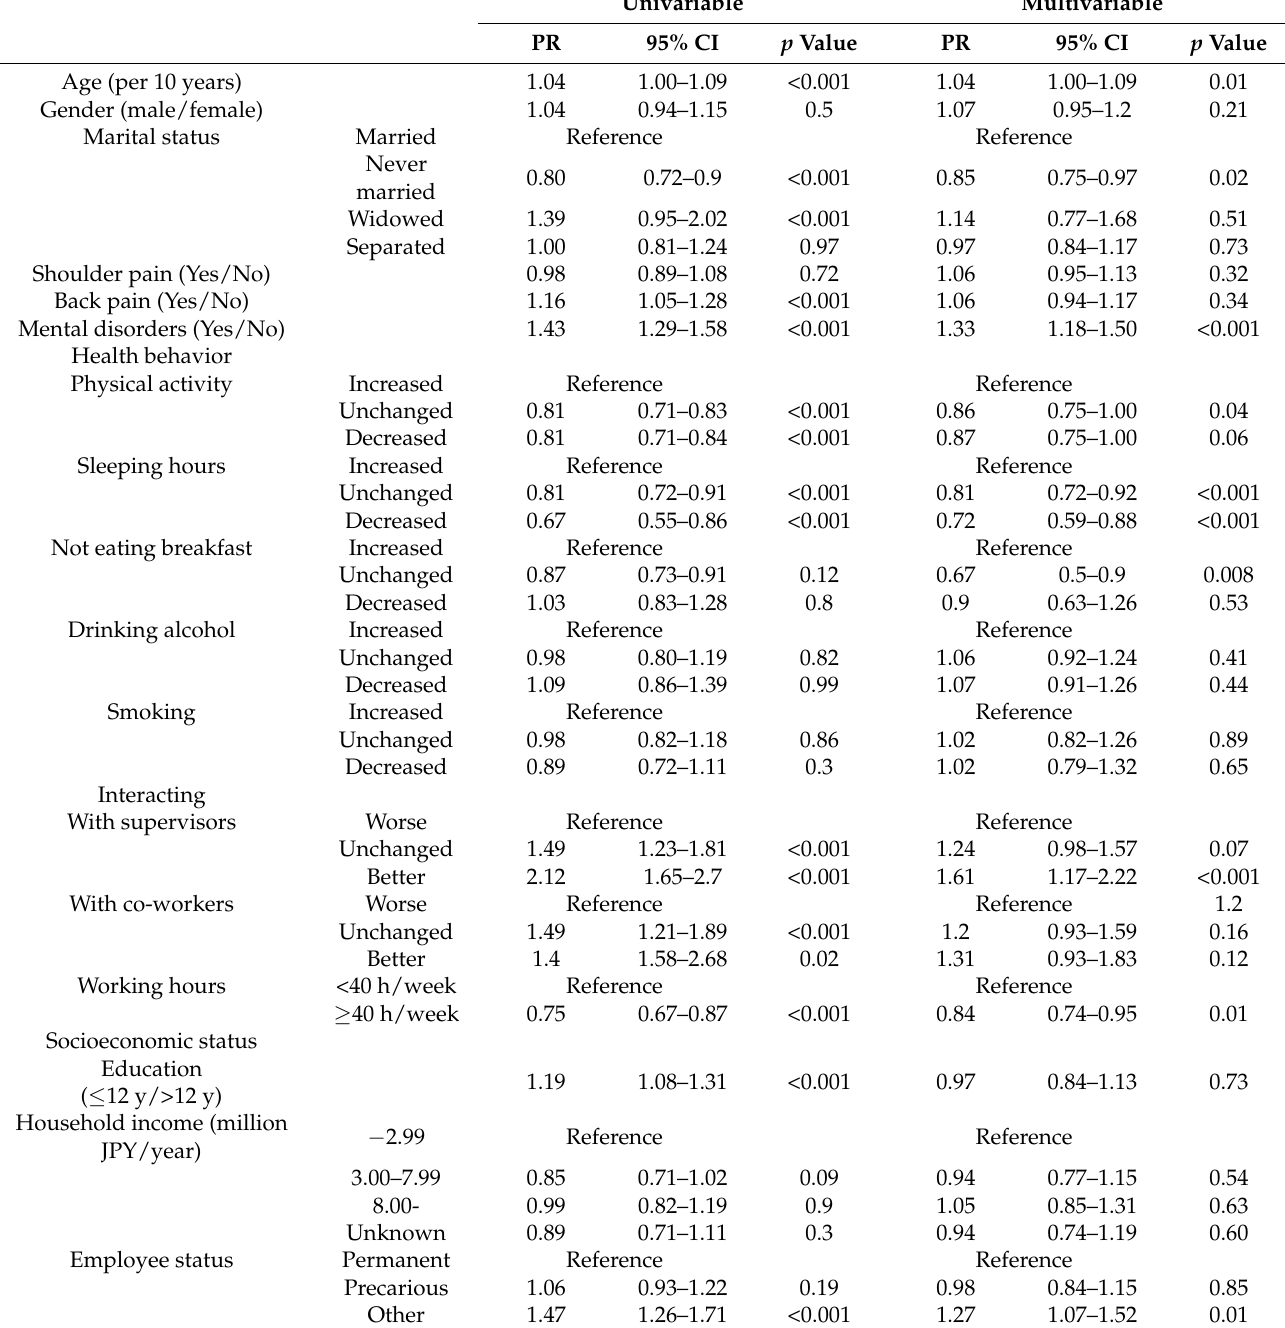
Table 2. Prevalence ratio and 95% confidence interval values for high work engagement among employees working from home using the Poisson regression model (univariable and multivariable